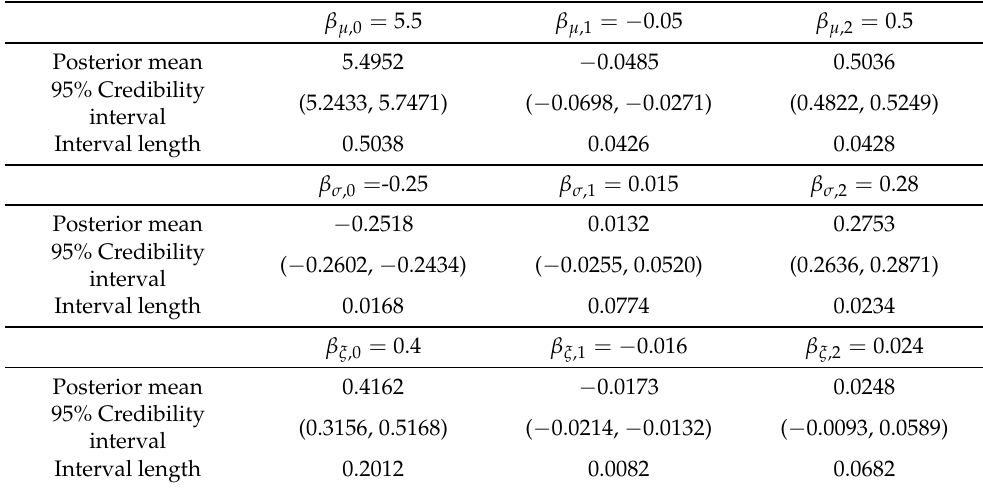
Table 3. Estimates for the regression coefficients of simulations with sample n = 5000